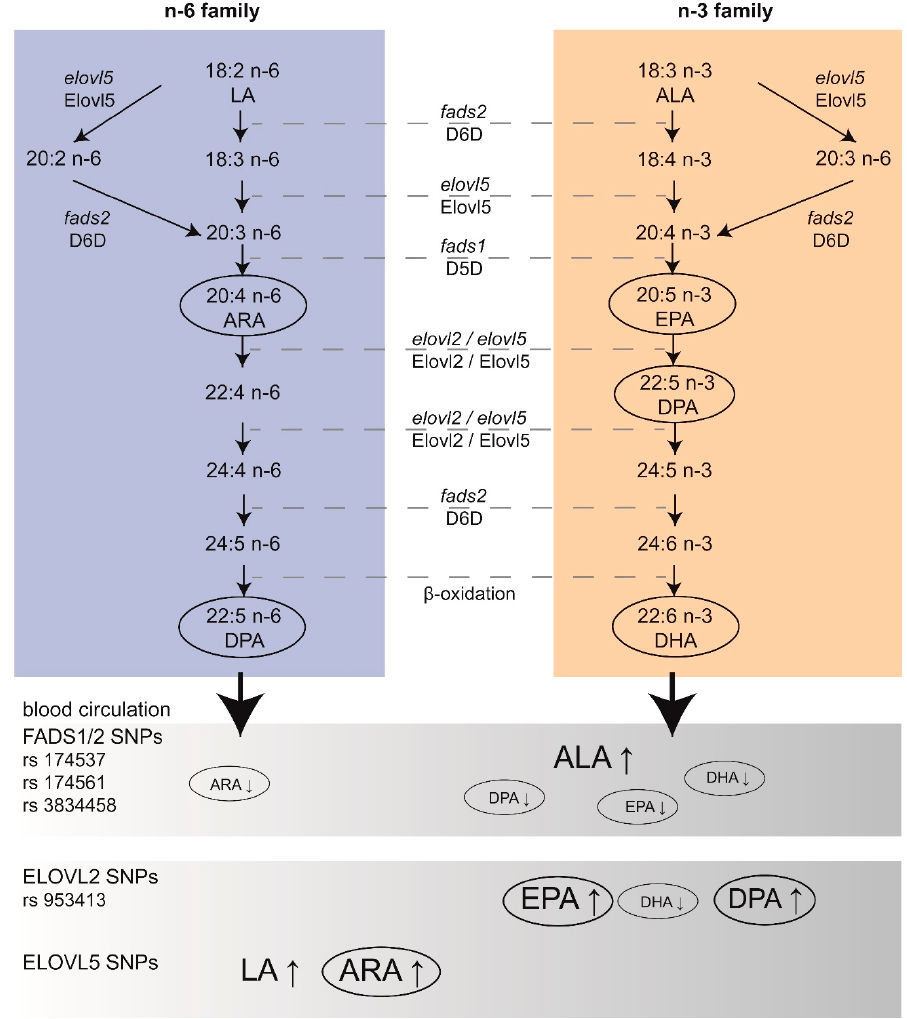
Figure 1. Single nucleotide polymorphisms (SNPs) within the metabolic pathways of n-3 and n-6 PUFAs lead to altered circulating levels of PUFAs. Desaturase enzymes (delta-5 desaturase (D5D) and delta-6 desaturase (D6D)) encoded by fatty acid desaturase genes 1 and 2 (fads1 and fads2 respectively), as well as elongase enzymes (elongase 2 (Elovl2) and elongase 5 (Elovl5)) encoded by elovl2 and elovl5 genes (respectively), are involved in desaturation and elongation of PUFAs from the n-6 (cyan) and n-3 (orange) families. Polymorphisms in those genes (SNPs) are associated with variations of plasma (grey) levels of LC PUFAs (represented by circles in the blood circulation). Bold letters represent higher amounts of LC PUFAs in the blood. fads: fatty acid desaturase; elovl: elongase; EPA: eicosapentaenoic acid; ARA: arachidonic acid; DHA: docosahexaenoic acid; ALA: α -linolenic acid; LA: linoleic acid; DPA: docosapentaenoic acid; D5D: delta-5 desaturase; D6D: delta-6 desaturase; Elovl5: elongase 5; Elovl6: elongase 6.